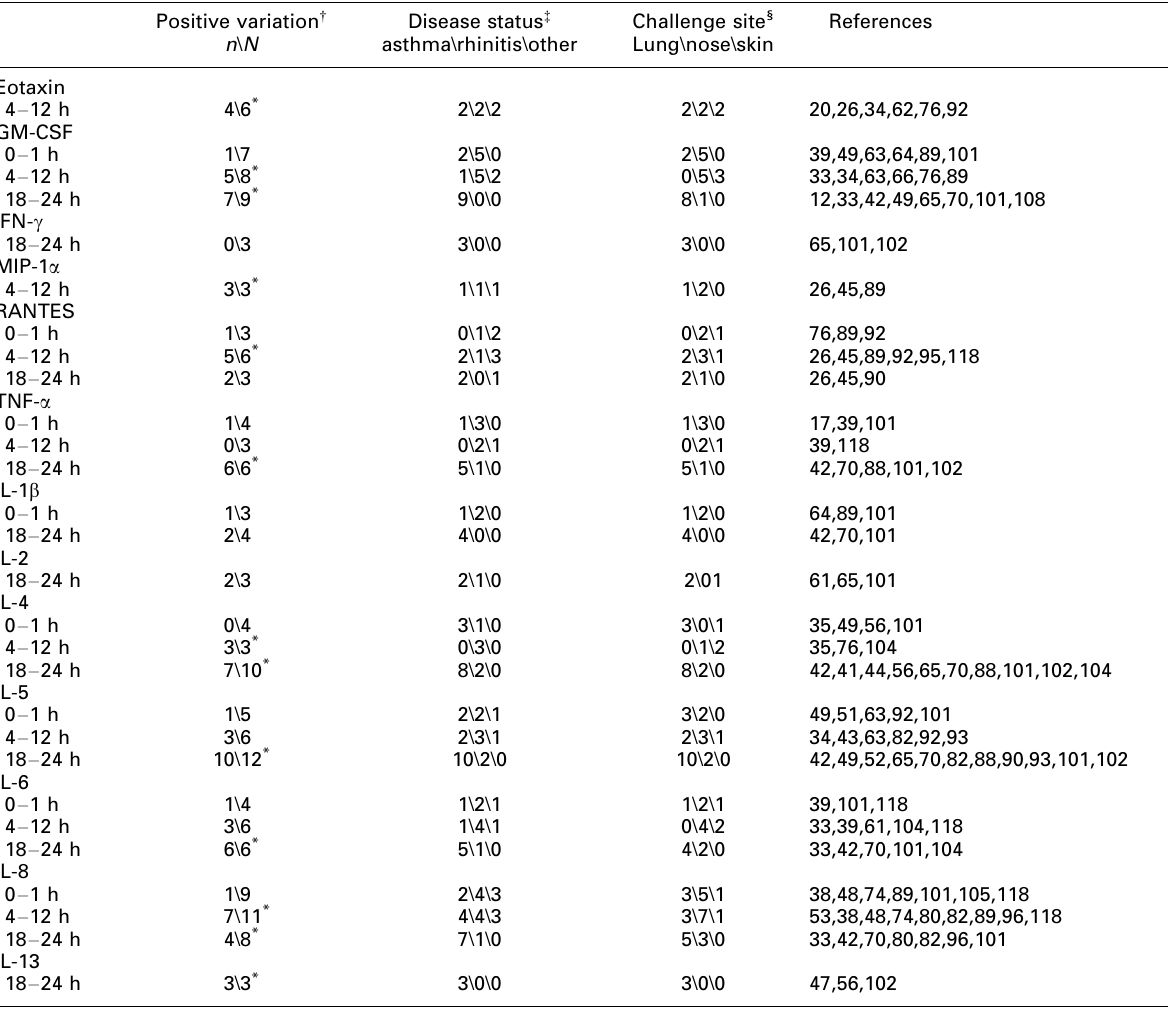
Table 1. Variation of cytokine protein levels in fluids collected after allergen challenge in atopic